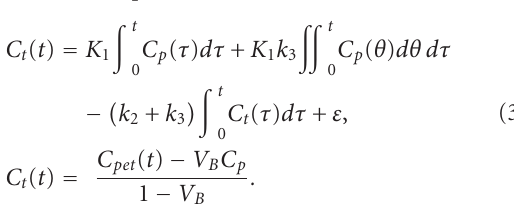
(1) Computer simulation Time activity curves for 100 pixels within a cluster were sim- ulated to investigate the influence of noise on parameter es- timation with conventional LLS and cLLS at various noise levels. The regular FDG model was used for the